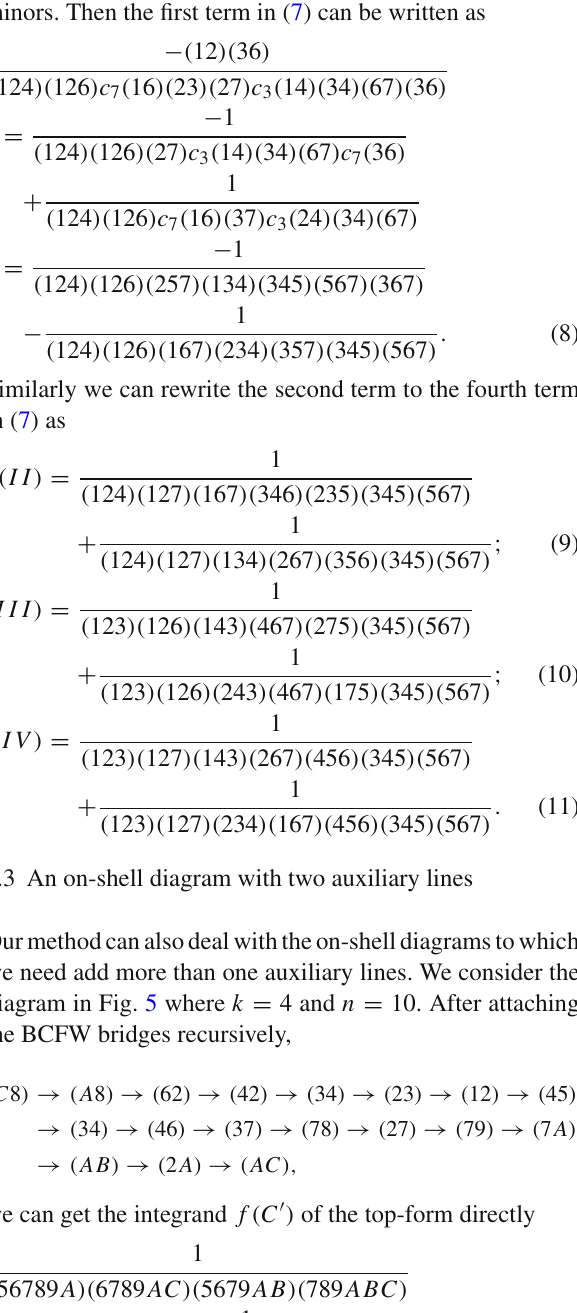
Table 3 Geometry constraints evolution for NMHV